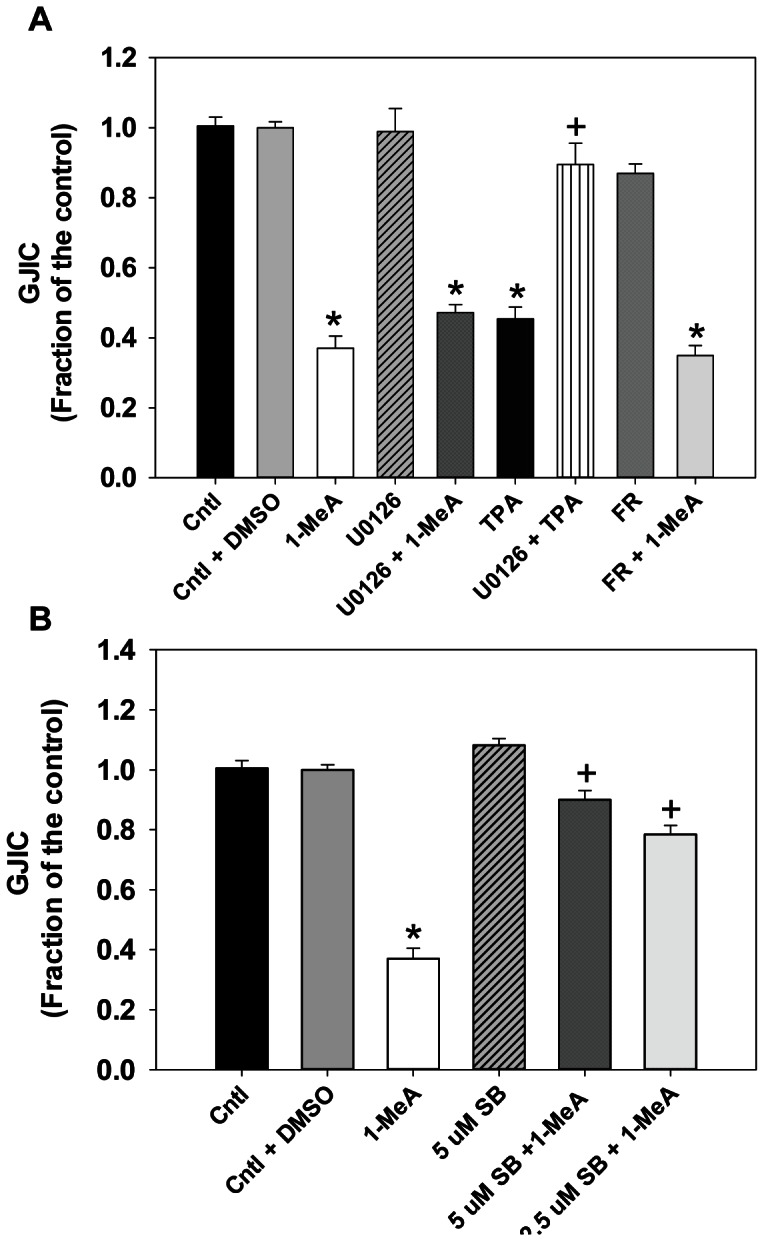
Reversal of 1-MeA-induced GJIC dysregulation using a p38 MAPK inhibitor.(A) U0126 (20 µM) and FR180204 (5 µM) were used to inhibit MEK or ERK1/2, respectively, prior to exposure to 1-MeA for 30 min. SL/DT assays were then done following 1-MeA treatment. TPA was also used as a positive control. Cntl, acetonitrile control; 1-MeA, 1-methylanthracene (75 µM, 30 min); U0126 alone (20 µM, 1 h prior); U0126+1-MeA, U0126 prior to incubation with 1-MeA; TPA (50 nM, 1 h), TPA alone; U0126+ TPA, U0126 prior to incubation with TPA; FR, FR180204 alone (5 µM, 1 h prior); FR +1-MeA, FR180204 prior to incubation with 1-MeA. Mean ± SEM presented with n = 3 per study, replicated 3 times. *p<0.05 compared to control;+p<0.05 compared to TPA treated cells. (B) SB203580 (2.5, 5 µM) was used to inhibit p38 1 h prior to exposure to 1-MeA for 30 min. SL/DT assays were then done following 1-MeA treatment. SB, SB203580 (2.5 or 5 µM, 1 h); SB +1-MeA, SB203580 prior to incubation with 1-MeA. *p<0.05 compared to control; +p<0.05 compared to 1-MeA treated cells.